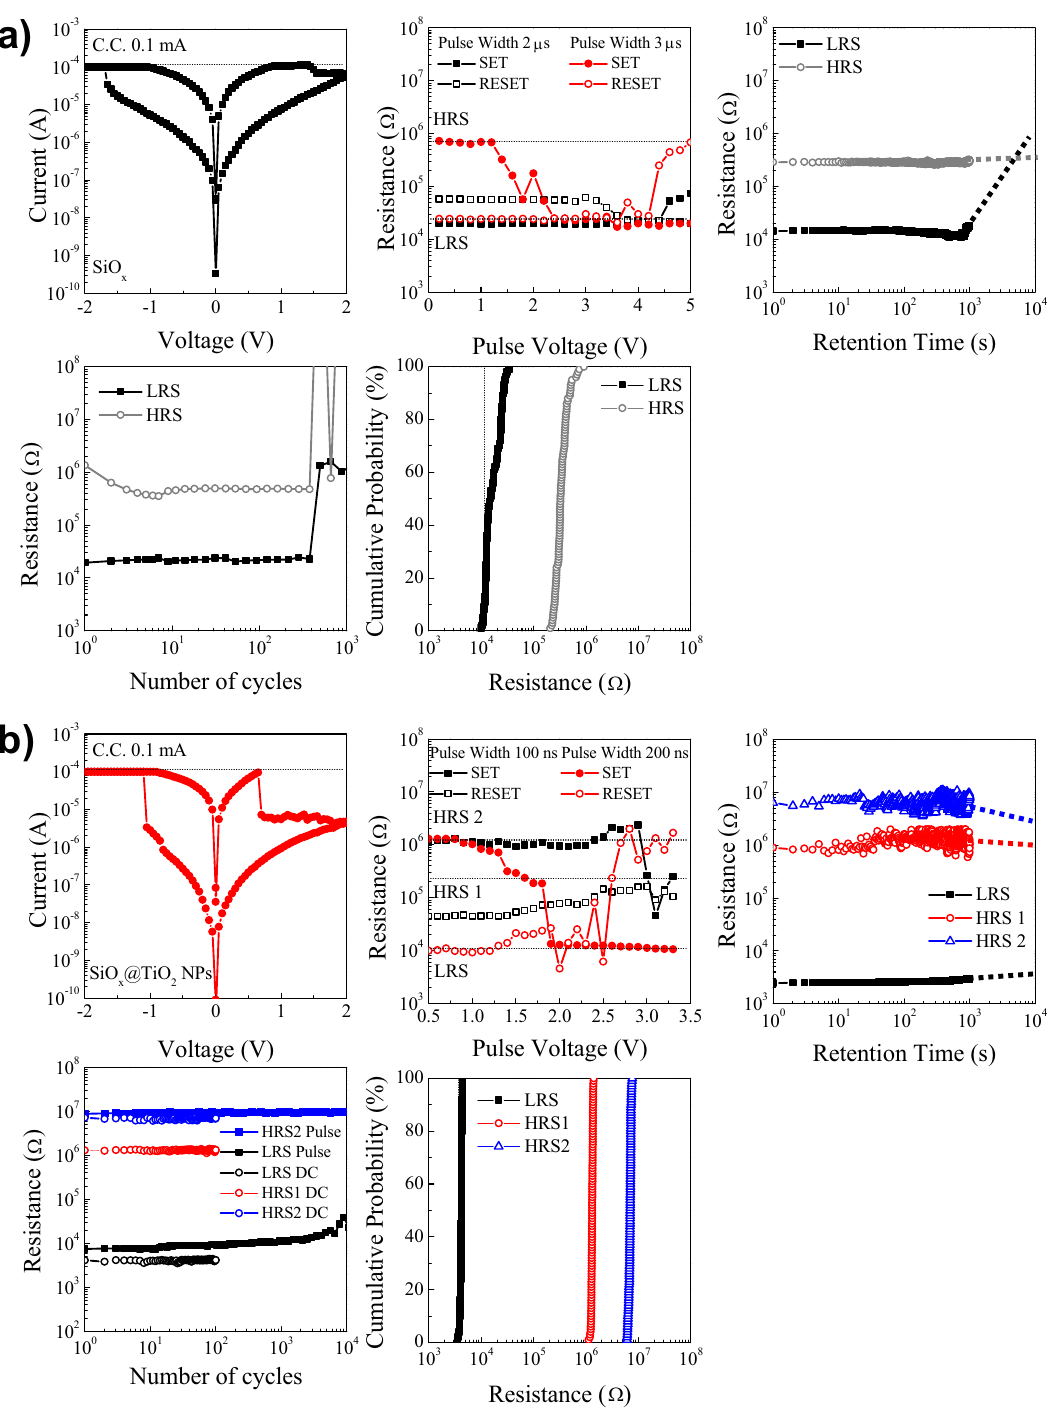
Figure 3. I–V characteristics, switching speed, retention (dotted lines indicate the expectation of lifetimes for the devices), endurance, and cycle-to-cycle variability of the ( a ) SiO x and ( b ) SiO x @TiO 2 NPs resistive switching